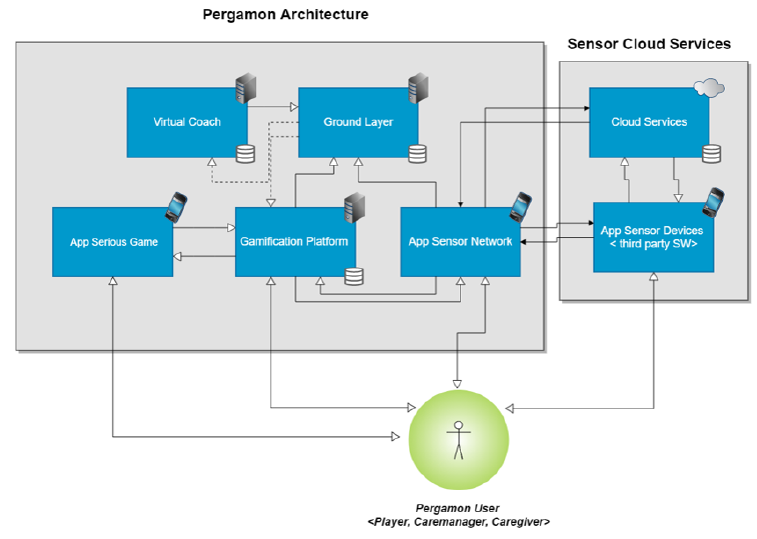
Figure 1. The PERGAMON